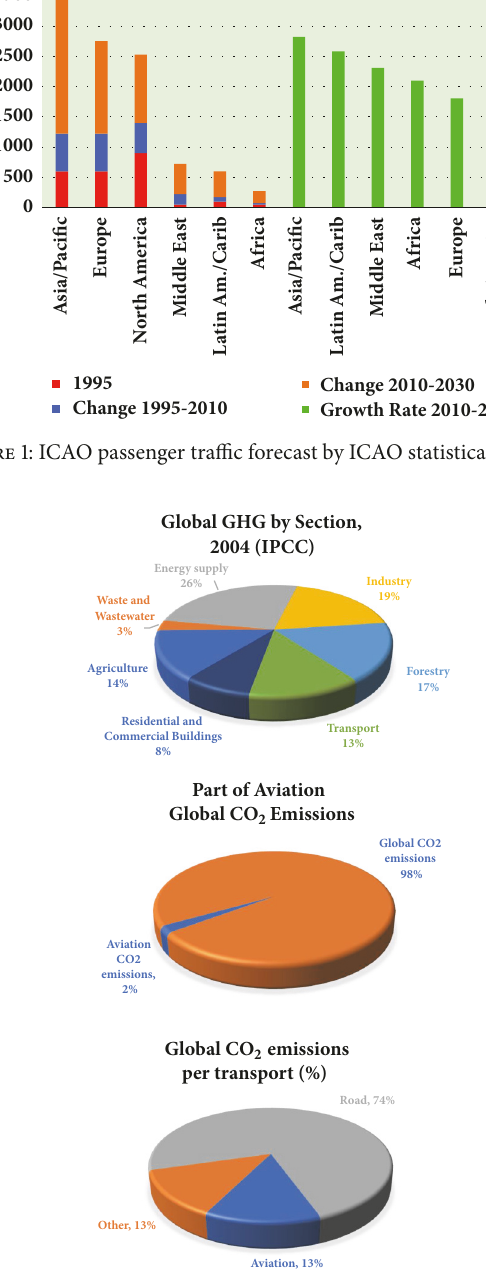
Figure 2: Aviation contribution to global 𝐶𝑂 2 emissions